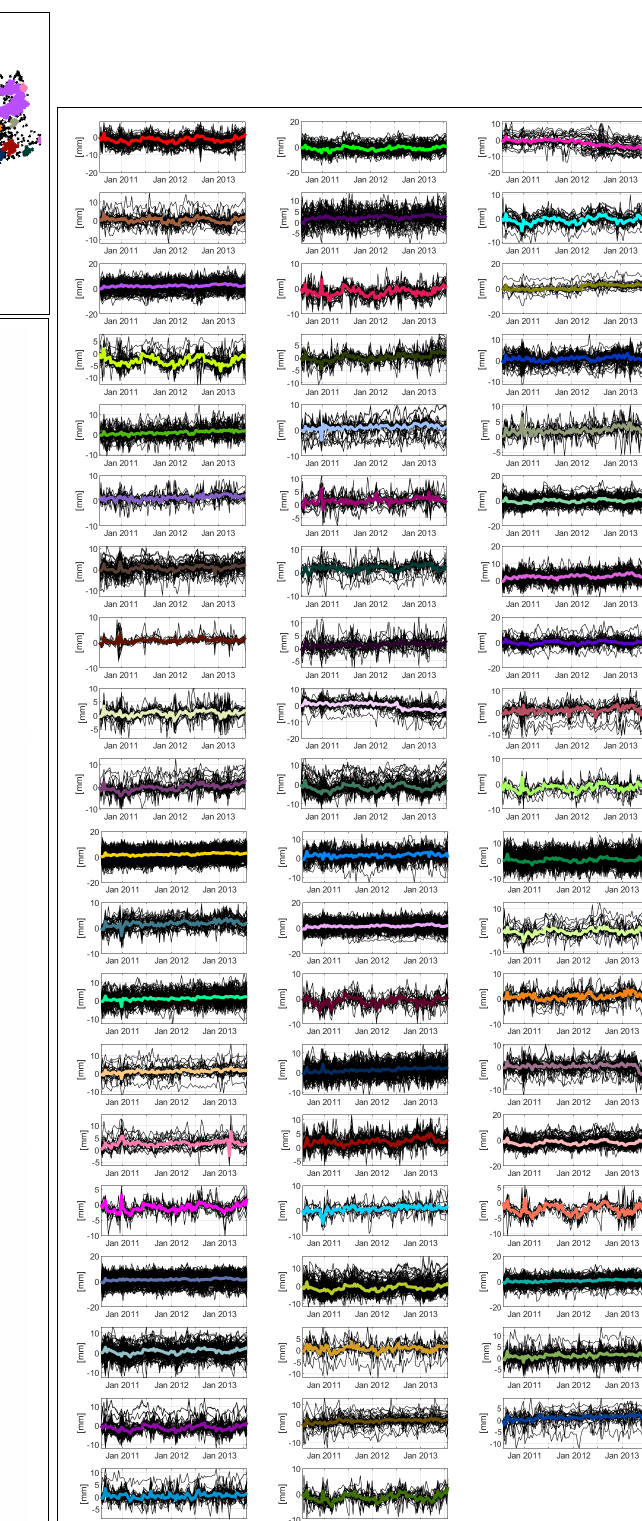
Figure 6. a) Embedding of the PS-points in 2d deformations space. The extracted clusters are shown in different colors. b) Top: PS-point on Reichstag all the colors correspond to a) and Figure 7. Middle: Mesh colored with the assigned PS-cluster. Bottom: Entropy for each mesh segment. A lower entropy indicates a good match between the cluster and the segment.